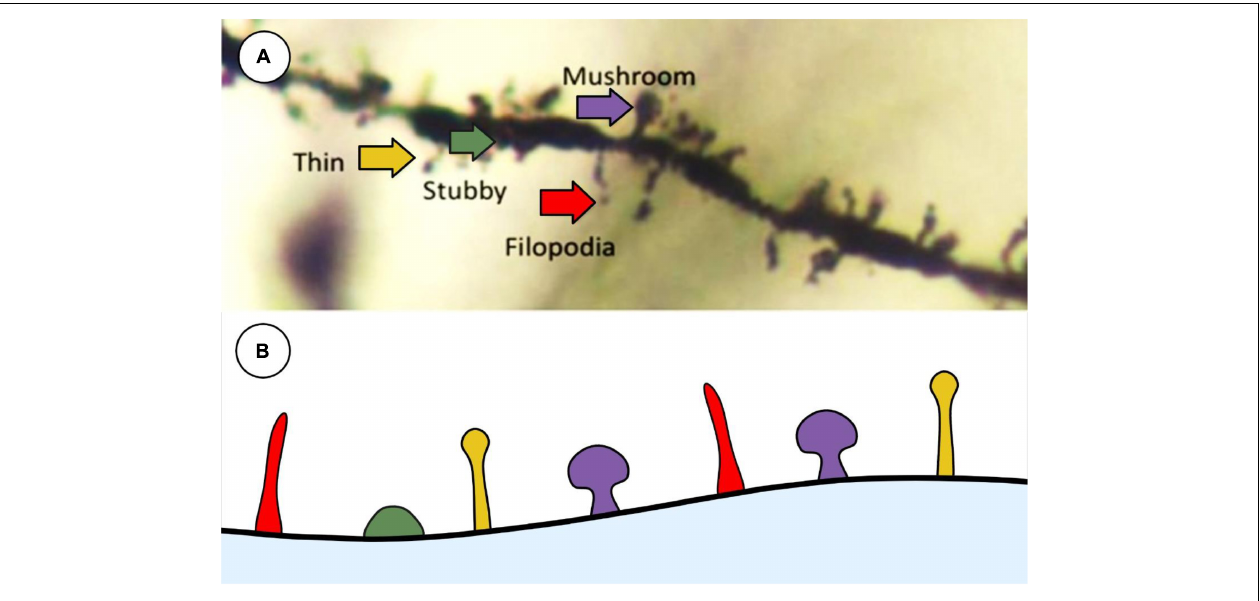
FIGURE 3 | Representative image of main spine types that are commonly used in histological analysis described by Peters and Kaiserman-Abramof (1970). (A) Golgi-stained neuron showcasing the 4 main types of spines: thin (yellow), stubby (green), filopodia (red), and mushroom (purple). (B) Schematic representation of the types of spines to illustrate differences between shapes. Created with